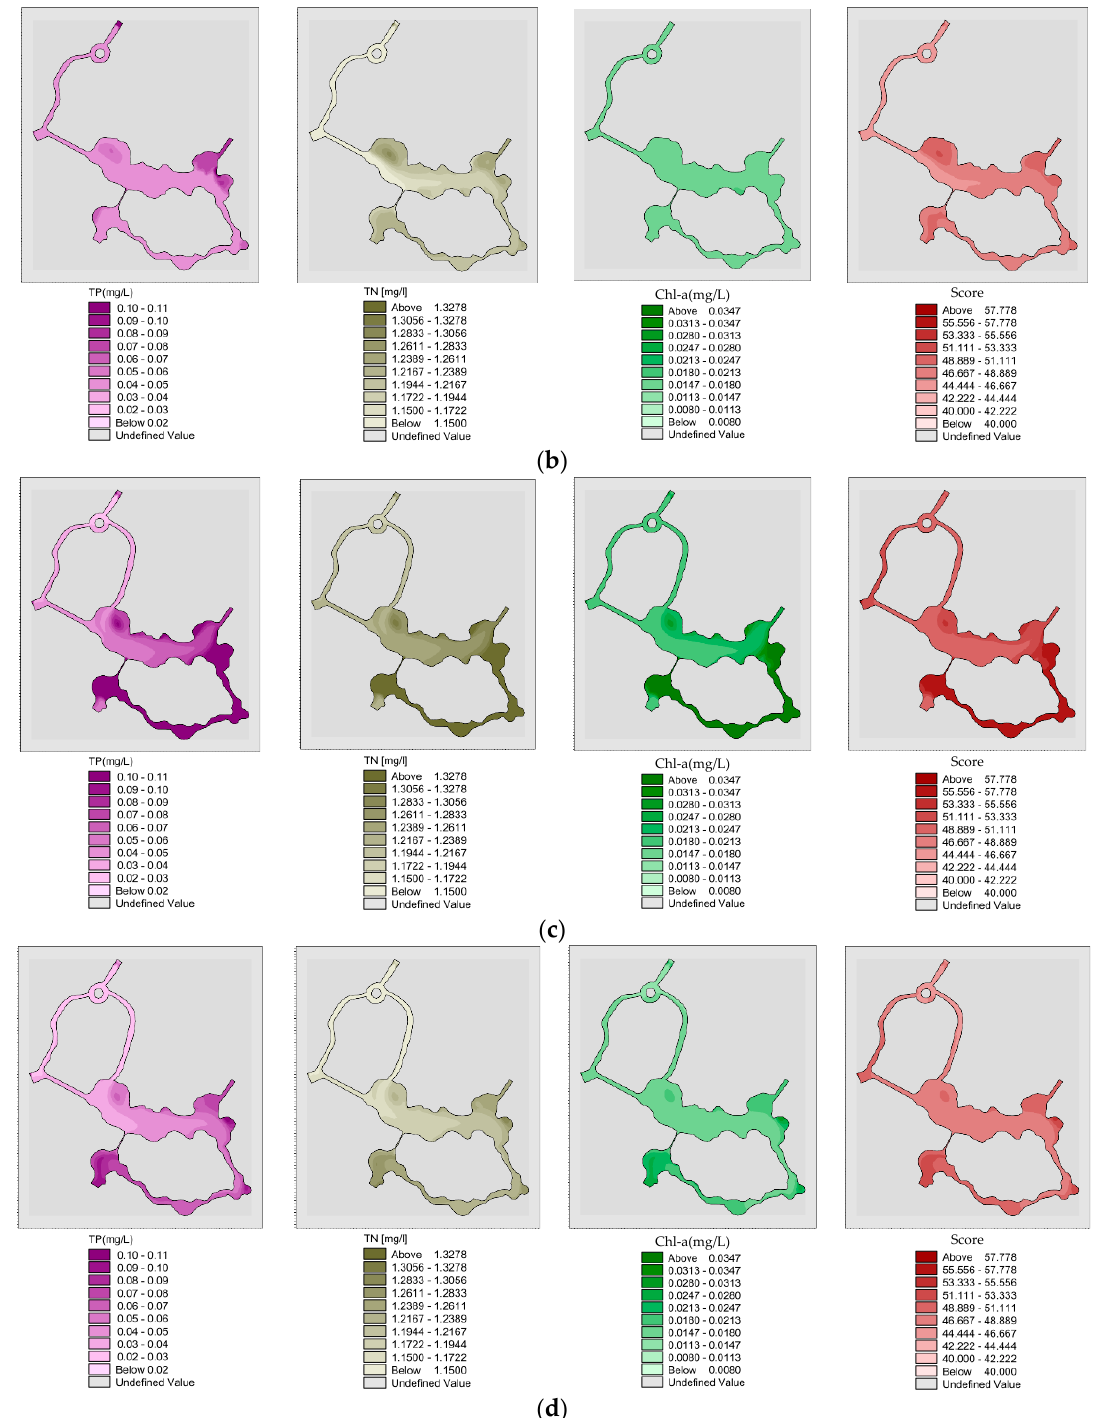
Figure 16. ( a ) Spatial distribution of “unilateral” river TP, TN, Chl-a and eutrophication scores after pumping 22 h in summer; ( b ) Spatial distribution of “unilateral” river TP, TN, Chl-a and eutrophication score after pumping for 30 h in summer, whereby the “unilateral” river model reached a completely steady state; ( c ) Spatial distribution of “bilateral” river TP, TN, Chl-a and eutrophication score after pumping for 22 h in summer; ( d ) Spatial distribution of “bilateral” river TP, TN, Chl-a and eutrophication score after pumping for 30 h in summer.